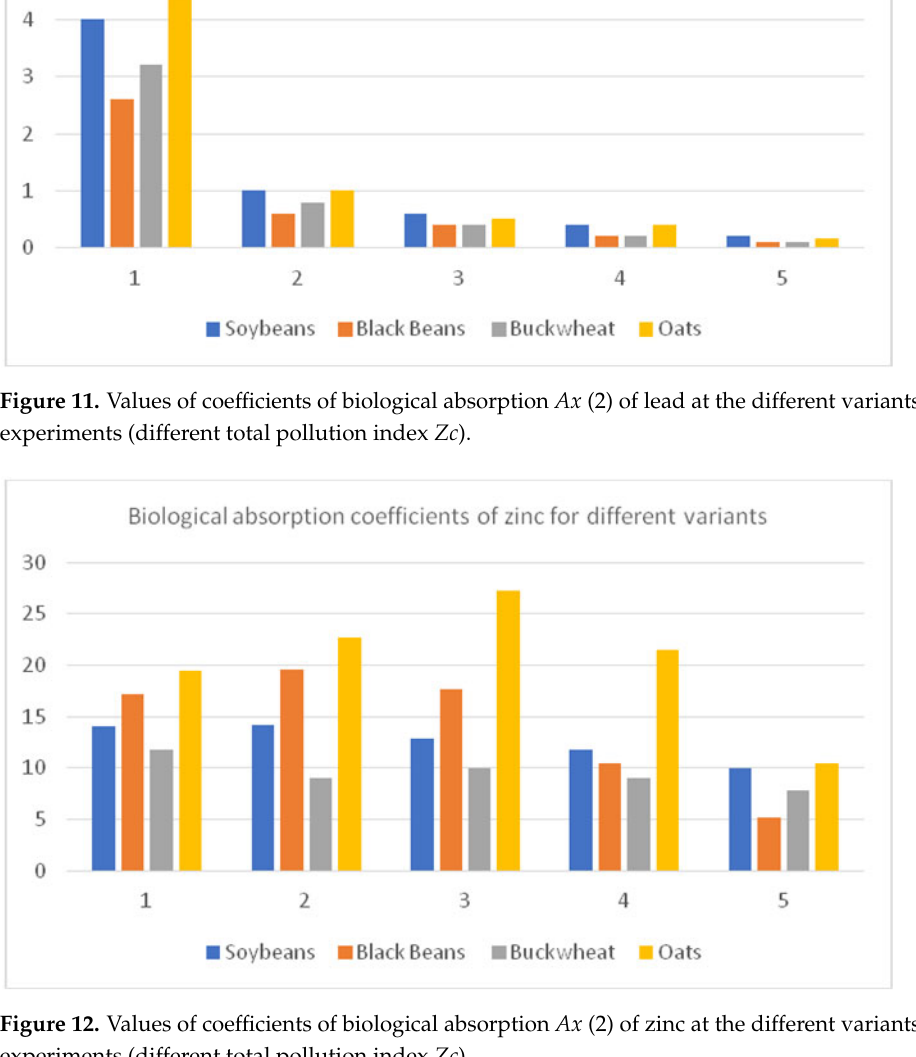
Figure 12. Values of coefficients of biological absorption A х (2) of zinc at the different variants of the experiments (different total pollution index Zc ).